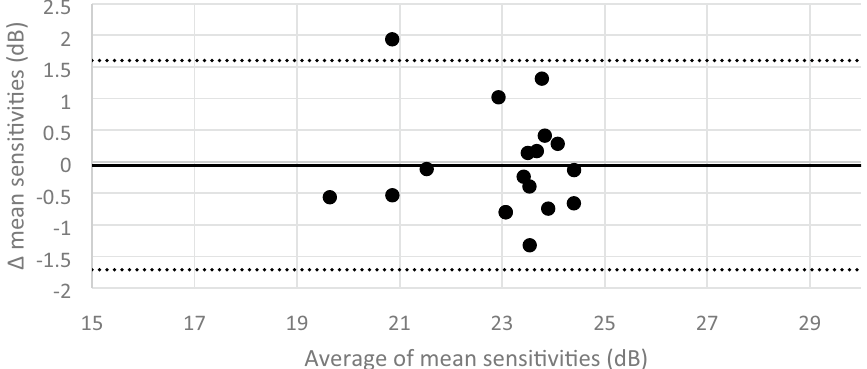
Figure 3. Bland–Altman plots for the average sensitivity threshold in 2 successive mesopic microperimetry tests when all grid points were included ( a , complete cohort of 25 eyes) and when only abnormal points at < 1.65 SD (5%) were included ( b , 18 eyes with at least 5 such points). The x-axis shows the mean of average sensitivity for each pair of repeated tests for each subject, the y-axis the difference between the average sensitivity in the two tests (first test–second test). The overall mean difference is represented by the central bold line, and the 95% Limits of agreement are marked by the upper and lower dashed